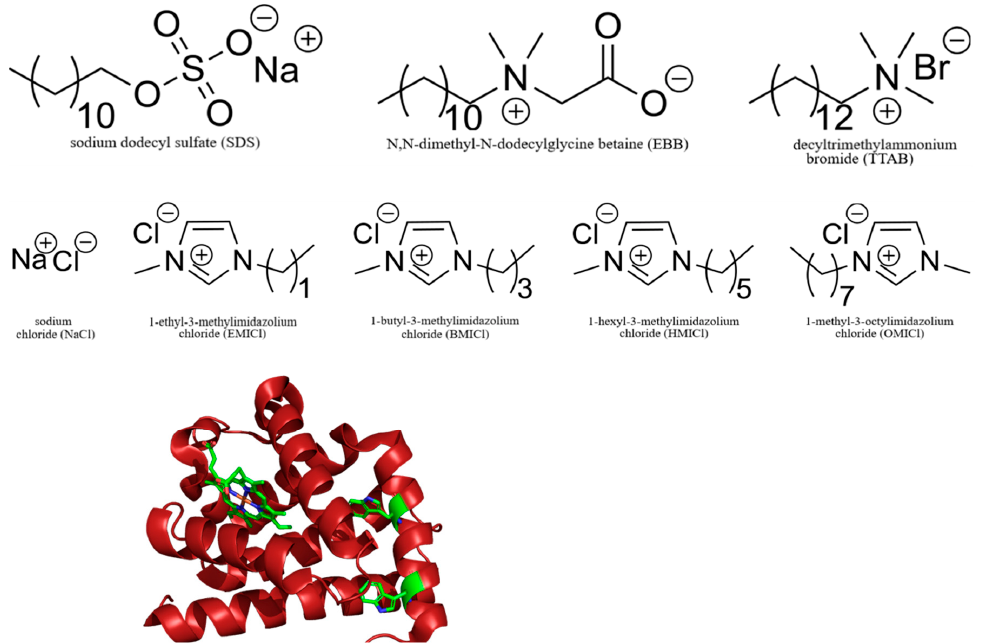
Figure 1. Structures of molecules used in this study. Detergents sodium dodecyl sulfate (SDS), Empigen BB ® (EBB), and tetradecyltrimethylammonium bromide (TTAB) are in the top row. Room temperature ionic liquids (RTILs) and the control NaCl are in the middle row. The three-dimensional (3D) structure of myoglobin from PDBID:5ZZE is shown at the bottom. In the myoglobin structure, the two Trp residues and the heme group are colored based on elemental composition, with green representing carbon.